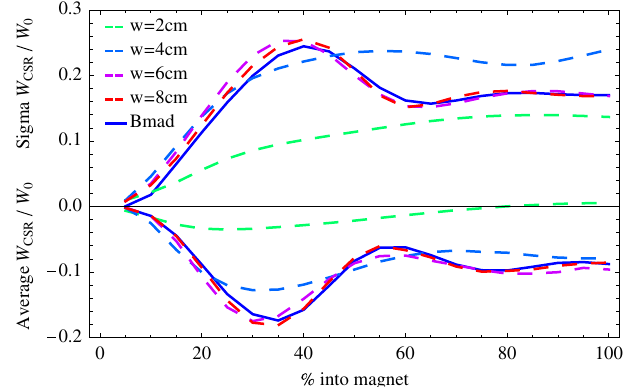
FIG. 15. (Color) Average and standard deviation of the CSR wake across the bunch distribution for parameter set G (the Cornell ERL’s CE magnet) for various chamber widths using the A&Y code, compared to Bmad, which has an infinite chamber width.